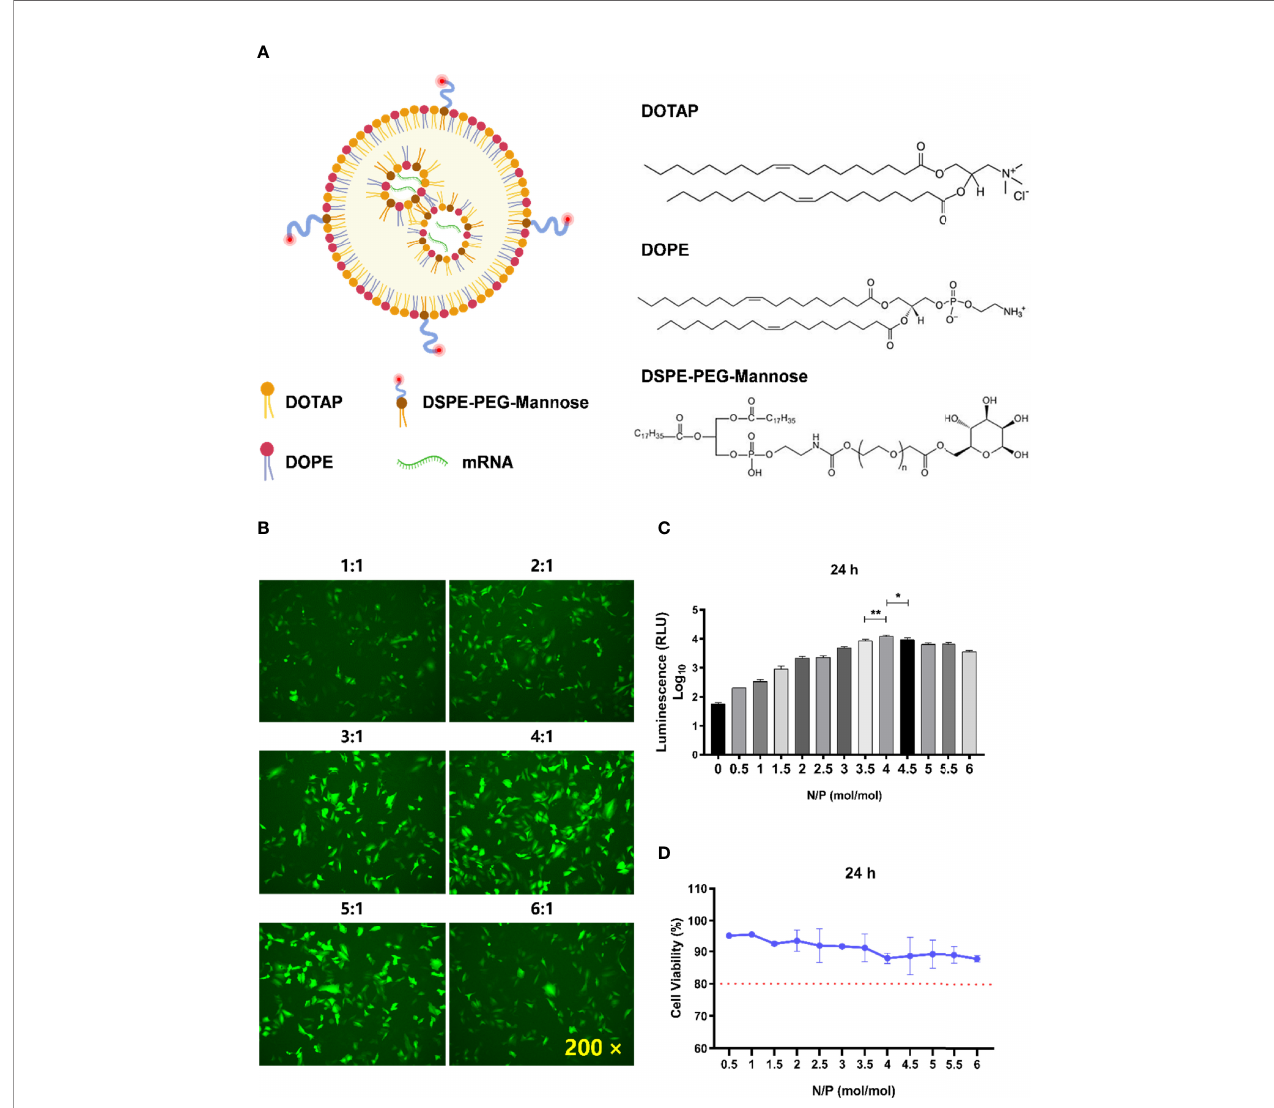
FIGURE 1 | Determination of the optimal N/P molar ratio between LNP-Man and mRNA. (A) The schematic illustration of LNP-Man/mRNAs. (B) LNP-Man and mEGFP were mixed in accordance with the N/P molar ratio of 1:1, 2:1, 3:1, 4:1, 5:1, and 6:1. After transfecting A549 cells for 24 h, the results were observed by a fl uorescence microscope. ×200 represents the magni fi cation of the microscope. (C) Increasing the gradient number of N/P molar ratios between LNP-Man and mLuc, the results were read by a microplate reader after the transfection of A549 cells for approximately 24 h. Error bars indicate standard error of mean, n = 3 for each group. * p< 0.05, ** p< 0.01, when compared with 3.5:1 and 4.5:1 by one-way ANOVA. (D) Toxic effects of LNP-Man/mLucs on A549 cells under different N/P molar ratios. The red dotted line represents 80% cell activity. Data were shown as mean ± SDs (n =